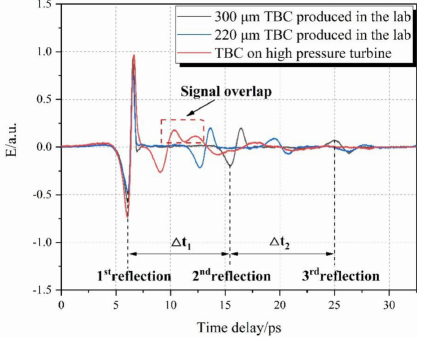
Figure 3. Overlapping terahertz time domain spectral